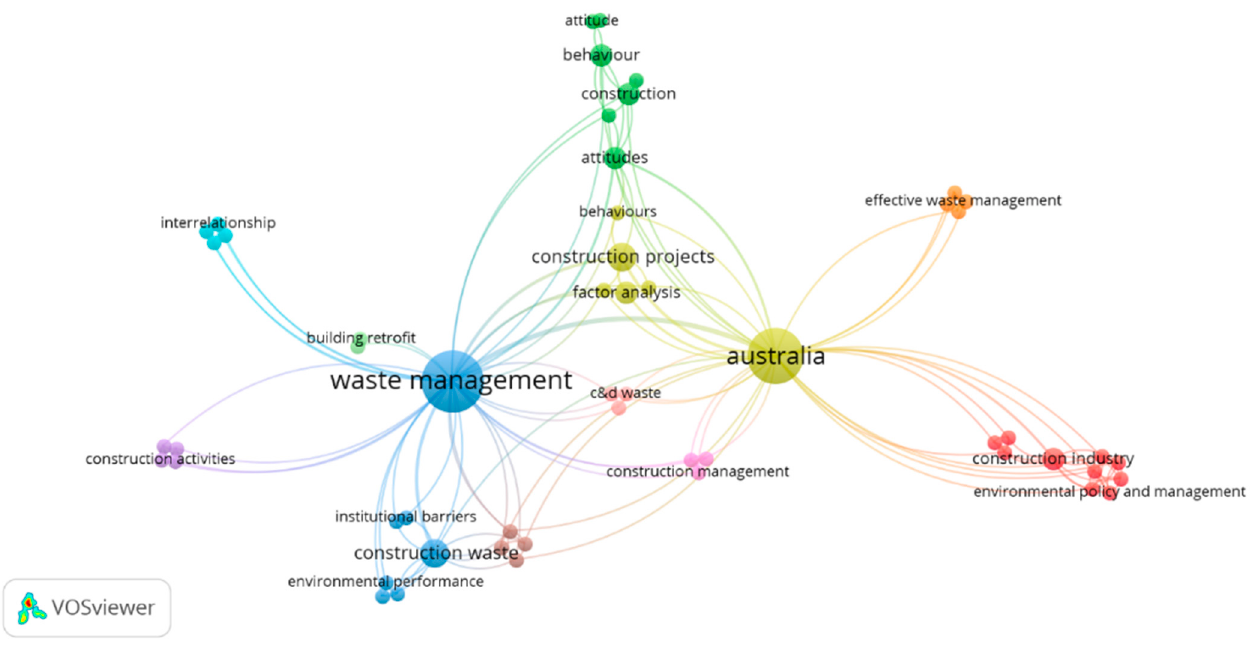
Figure 4. Co-occurrence of author keywords in C&DWM research in Australia.